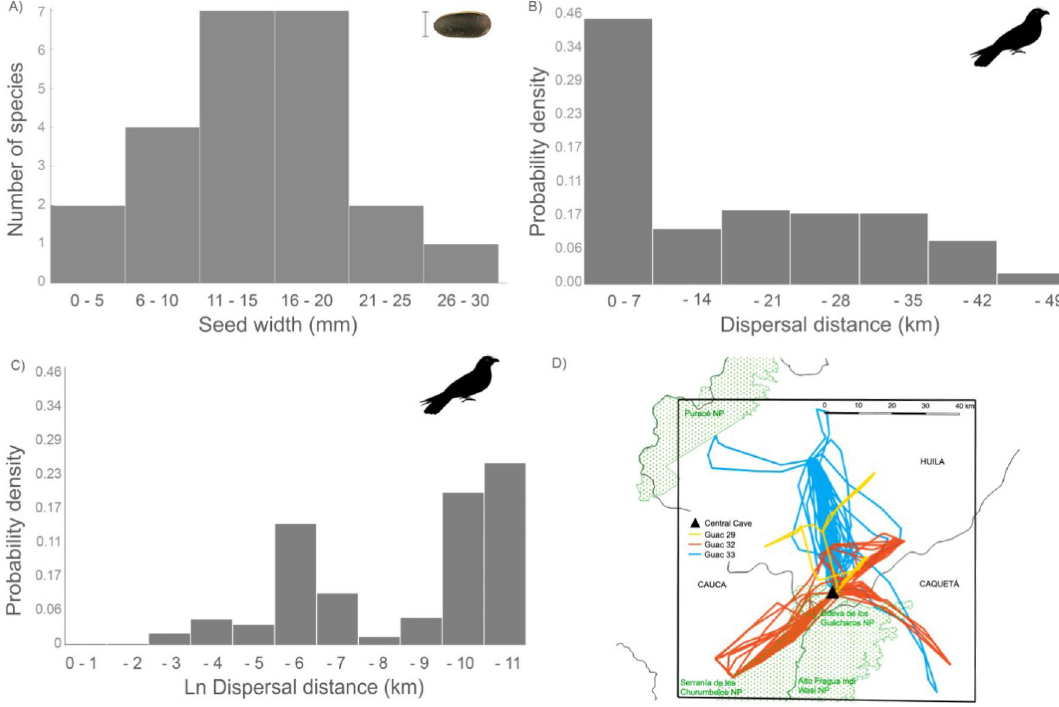
Figure 1. The role of oilbirds as seed dispersers. ( A ) Number of species dispersed by oilbirds in relation with the seed width. ( B ) Dispersal distances generated by oilbirds in Cueva de Los Guácharos National Park, Colombia, derived from the times of highest chance of gut delivery. ( C ) Dispersal distance with a logarithmic transformation. ( D ) Map showing the travel paths of three individuals (each with different colors, yellow corresponding to the one monitored in non-reproductive